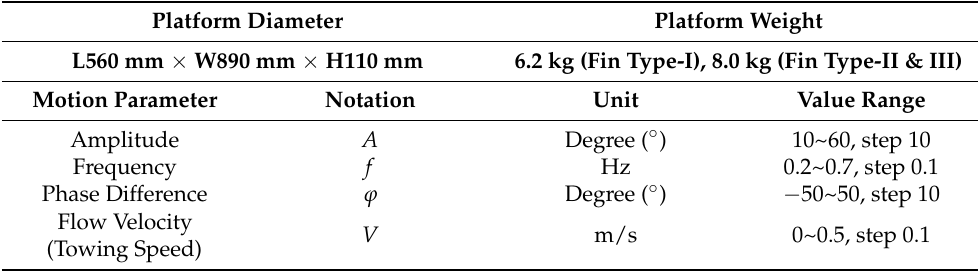
Table 1. Robot Platform and Motion Parameter Information of the Hydrodynamic Experiment.